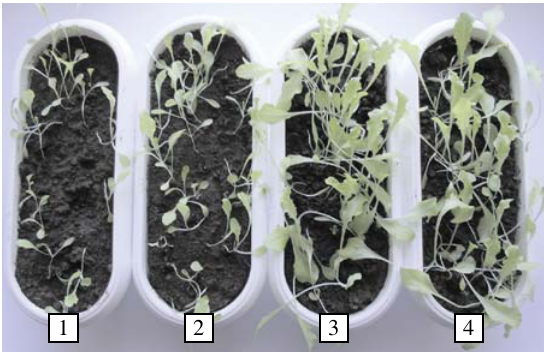
Fig 1. Lettuce samples were grown in substrates of different